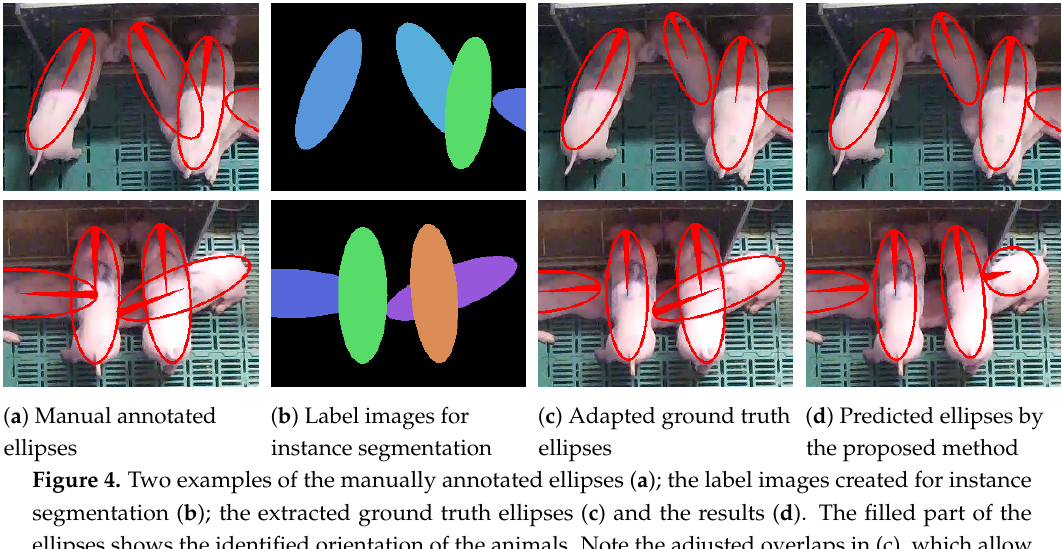
Figure 4. Two examples of the manually annotated ellipses ( a ); the label images created for instance segmentation ( b ); the extracted ground truth ellipses ( c ) and the results ( d ). The filled part of the ellipses shows the identified orientation of the animals. Note the adjusted overlaps in (c), which allow a comparison with the predicted ellipses. The lower picture in (d) shows a faulty